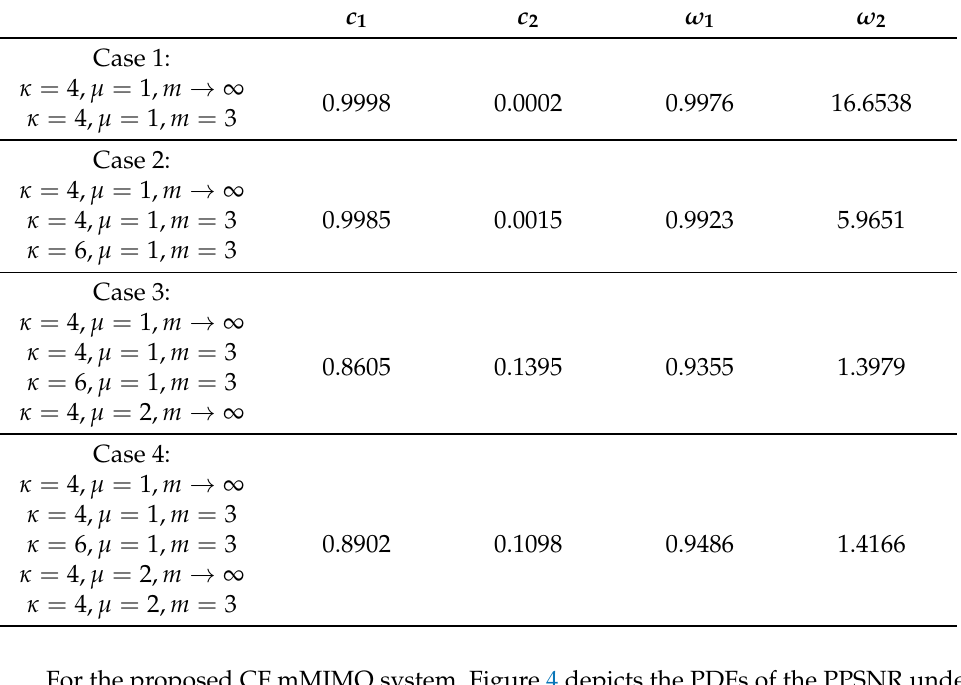
Table 2. The second-order approximate parameters in different cases shown in Figure 3. c 1 c 2 ω 1 ω